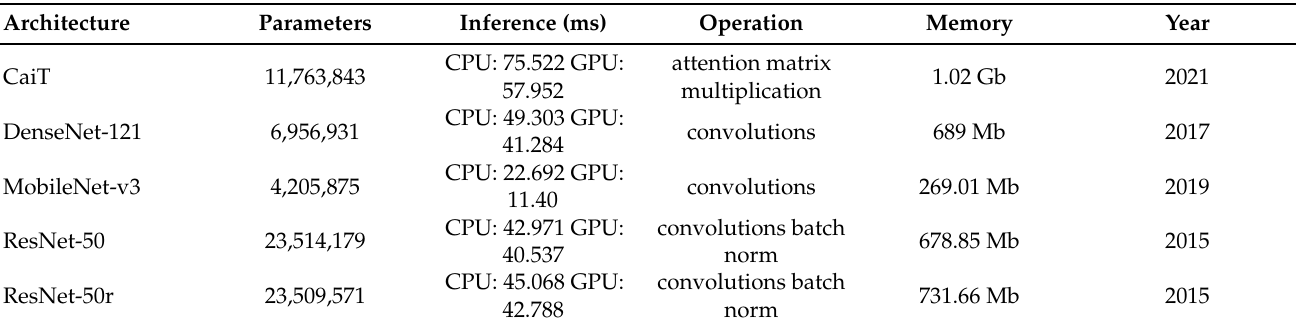
Table 1. Architectures and their trainable parameters per architecture considered for the classification of COVID-19 in CT chest scans (3